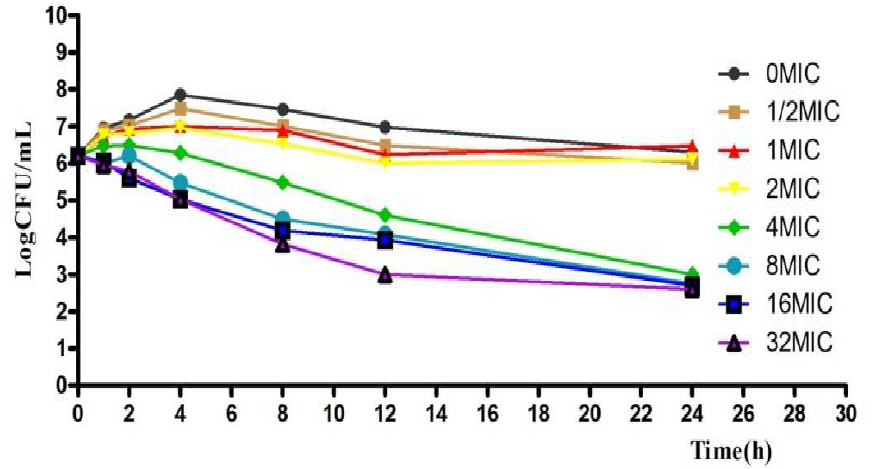
Figure 2. In vitro antibacterial of acetylkitasamycin against S. suis in MHB.